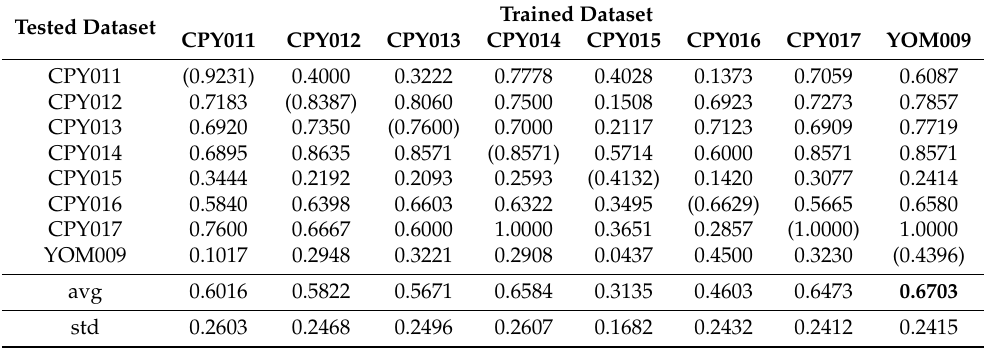
Table 14. The F1-scores of the E3 models when testing with the dataset from the same station (shown in the bracket) and different